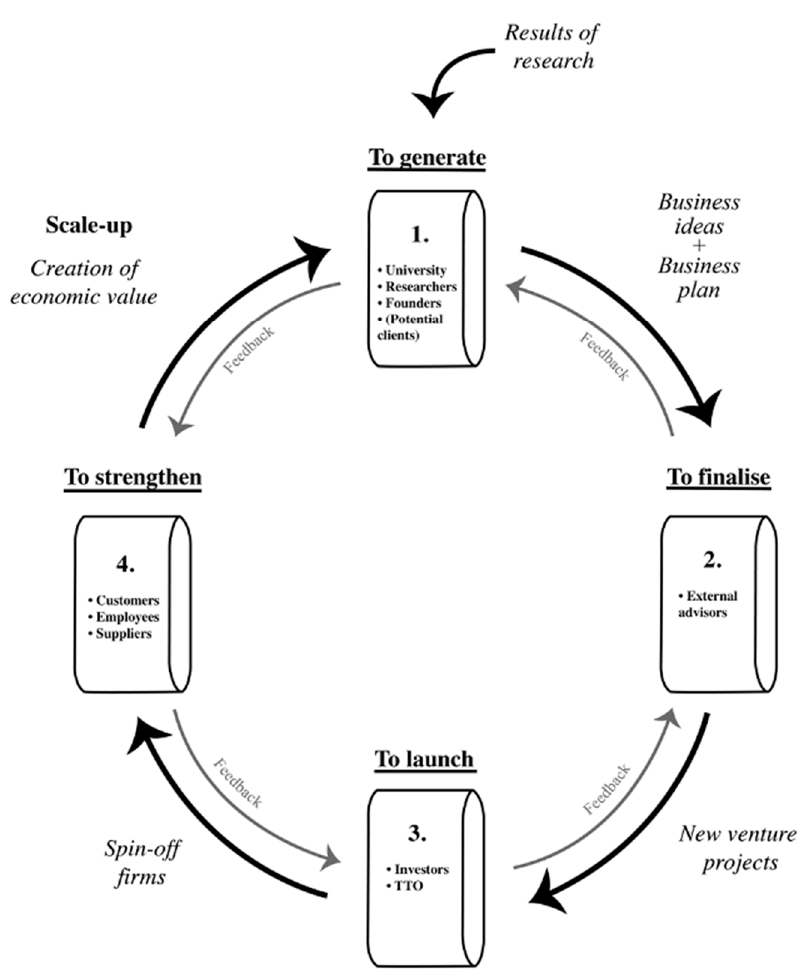
Figure 8. Conceptual framework made by Ndonzuau et al. (2002) adapted in the shape of a circle. Another question polled whether the respondents who do not use a